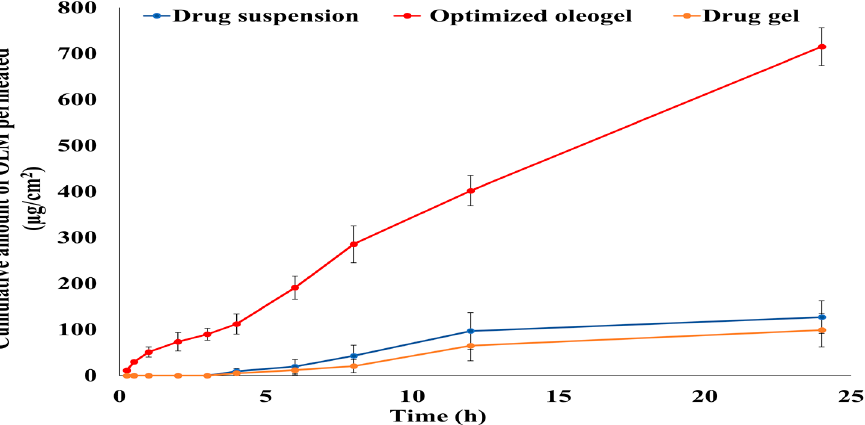
Figure 5. Ex vivo permeation pro fi le of OLM from the optimized oleogel formulation in comparison with the drug suspension and gel through newly born rat skin. Presented data are the mean ± SD (n =